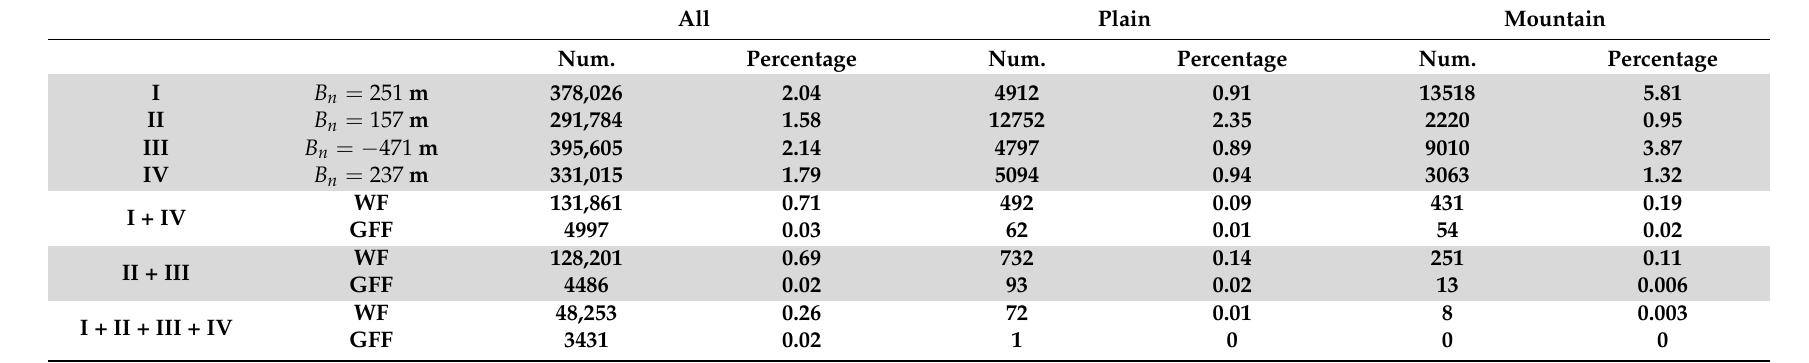
Table 3. Number and percentage of the invalid cells in the DEM. All Plain Mountain Num. Percentage Num.